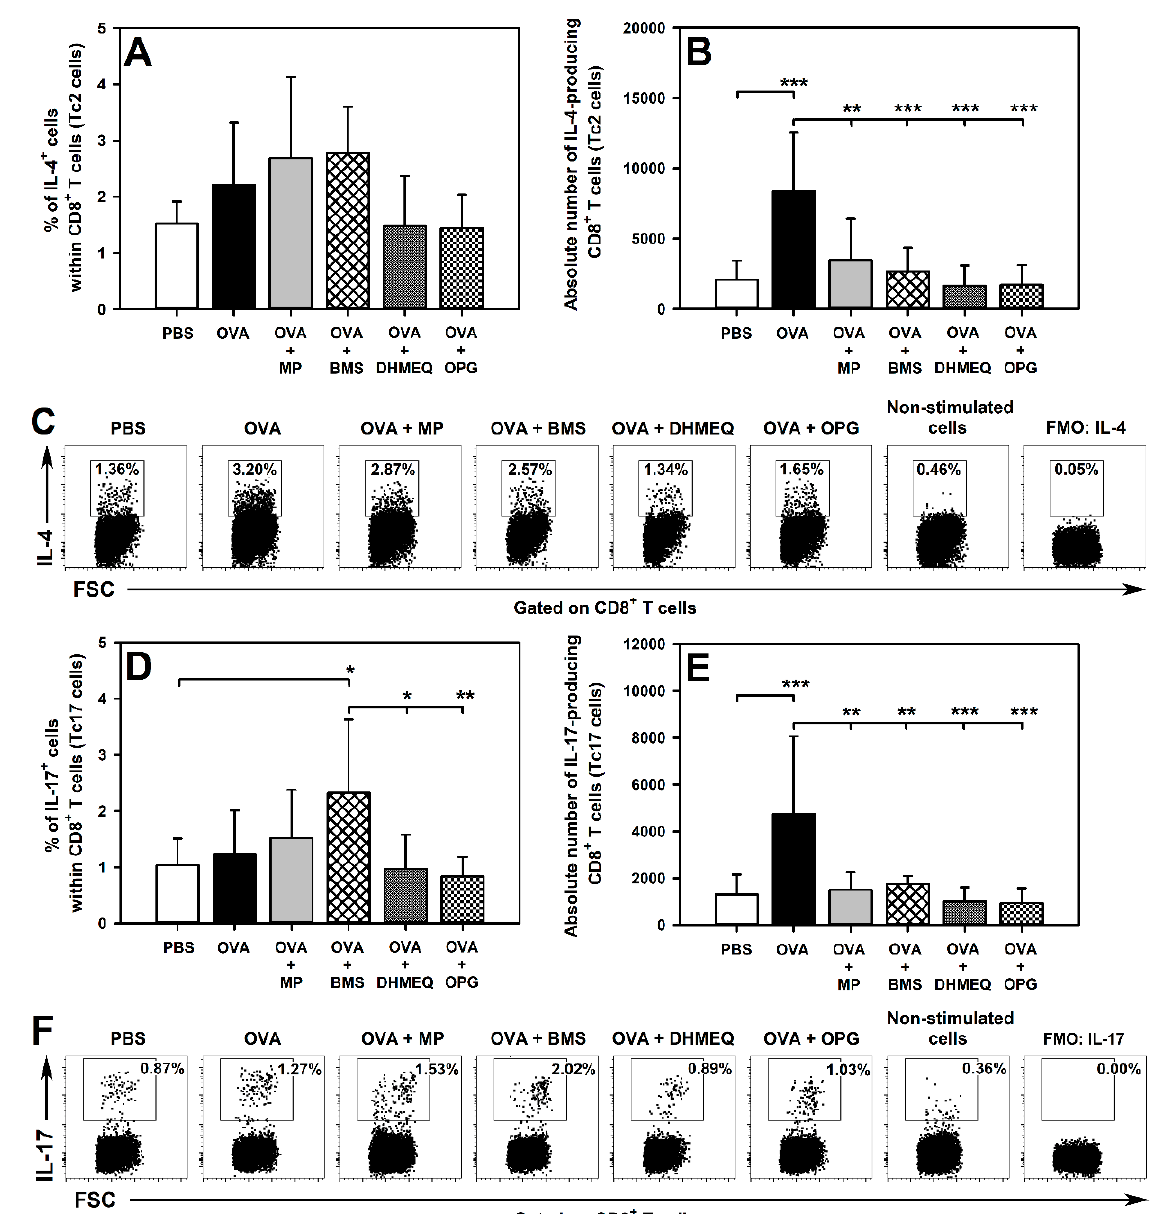
Figure 6. Effect of inhibitors of IKK (BMS-345541 (BMS)), NF- κ B translocation (dehydroxymethylepoxyquinomicin (DHMEQ)) and RANK/RANK-L interaction (osteoprotegerin (OPG)), and glucocorticosteroid (methylprednisolone (MP)) administration on the number of IL-4- and IL-17-producing CD8 + T cells. The relative count ( A , D ) is expressed as a percentage of IL-4- or IL-17-producing cells within CD8 + T cells. The absolute count ( B , E ) represents the number of IL-4- or IL-17-producing CD8 + T cells per lung sample collected from individual mice. * p < 0.05, ** p < 0.01, *** p < 0.001. Examples of dot plot cytograms showing the distribution of IL-4- or IL-17-producing and non-producing cells within CD8 + T cells ( C and F , respectively).